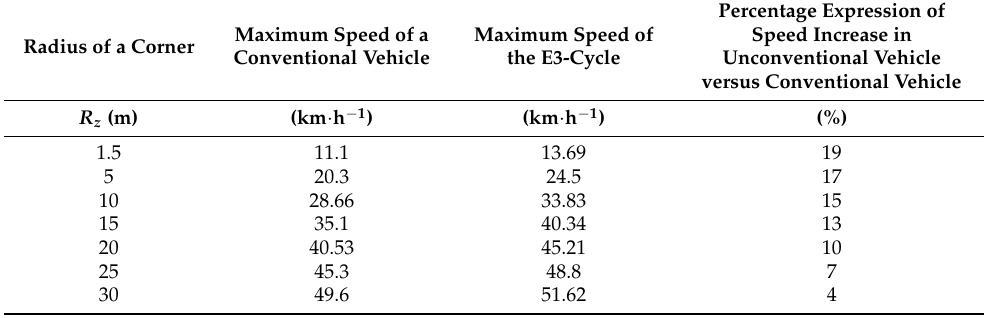
Table 2. Comparison of the theoretically obtained maximum vehicle speeds in the course of cornering.